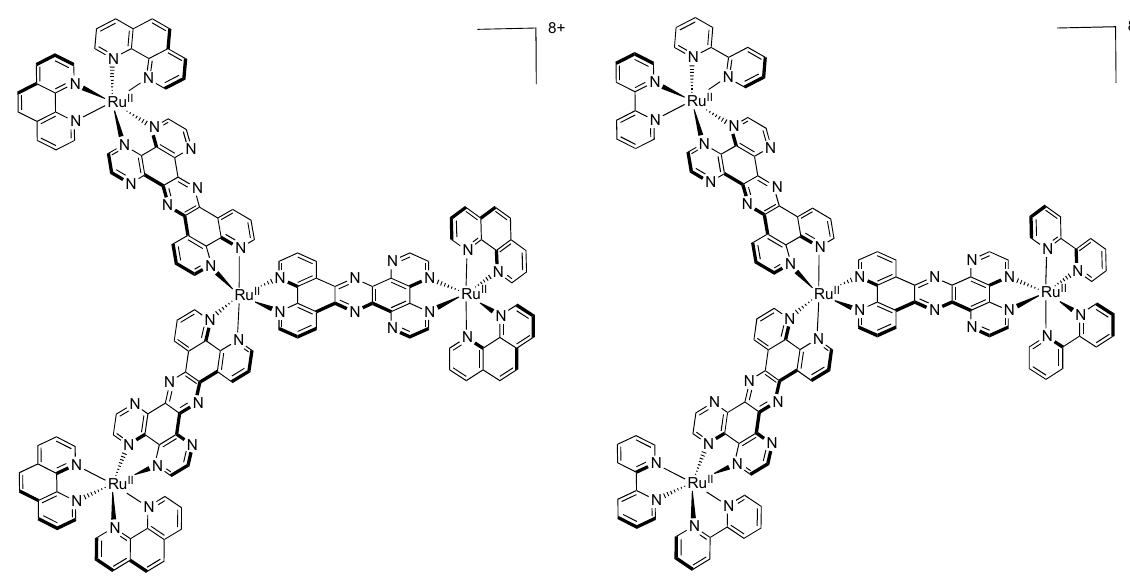
] } 8+ (left) and {Ru[PHEHAT-Ru(bpy) 2 3